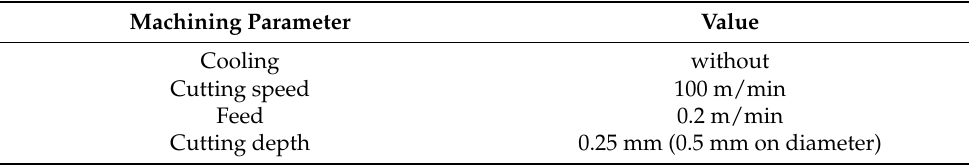
Table 3. Machining